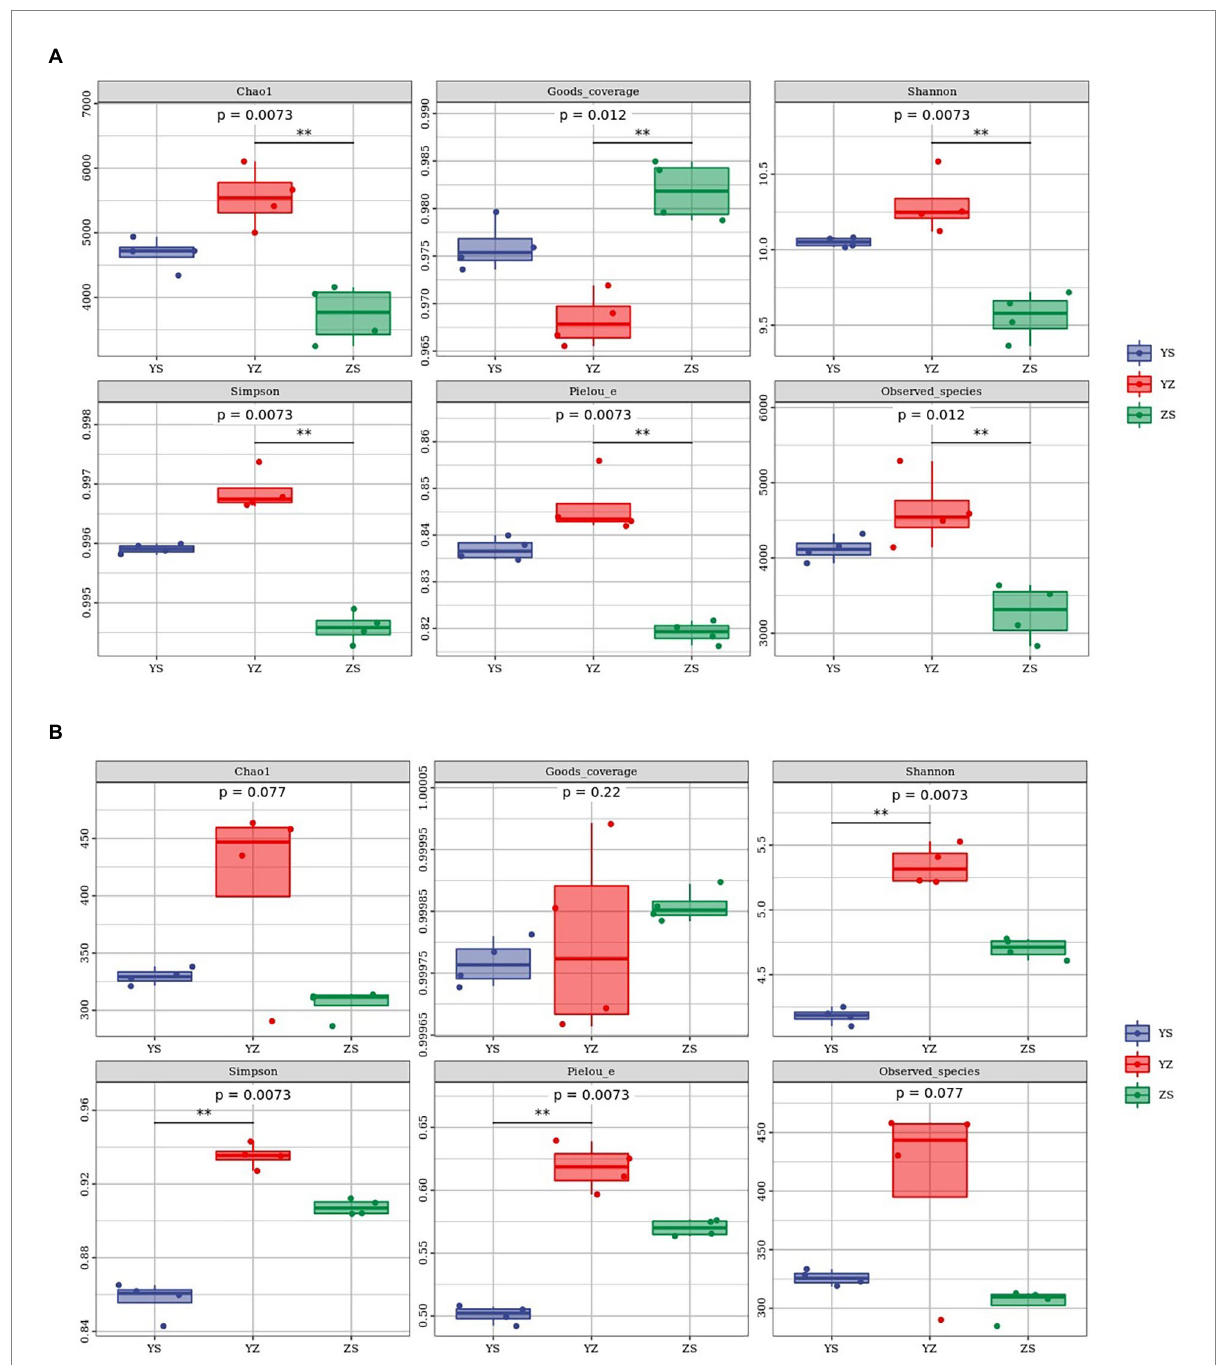
FIGURE 3 Litter microbial diversity index in YS, YZ and ZS. (A) Alpha diversity analysis of leaf litter bacterial community. (B) Alpha diversity analysis of leaf litter fungal community. YS: Populus × canadensis Moench; YZ: Populus × canadensis Moench- Pinus sylvestris var. mongolica ; ZS: Pinus sylvestris var. mongolica. ** meant significant difference at 0.01